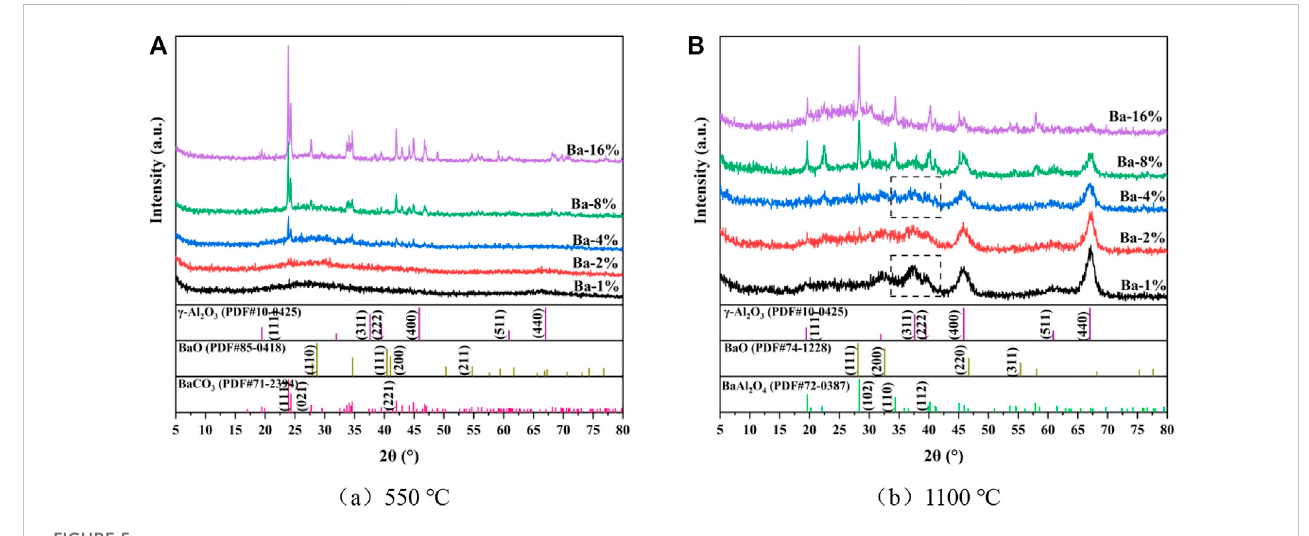
FIGURE 5 XRD pattern of Ba-doped sample calcined at 550 ° C and aged at 1,100 °